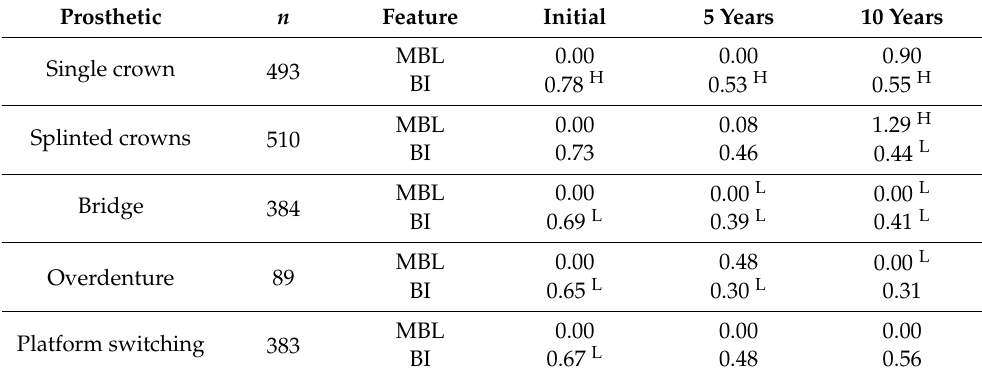
Table 4. The prosthetic solutions examined in this